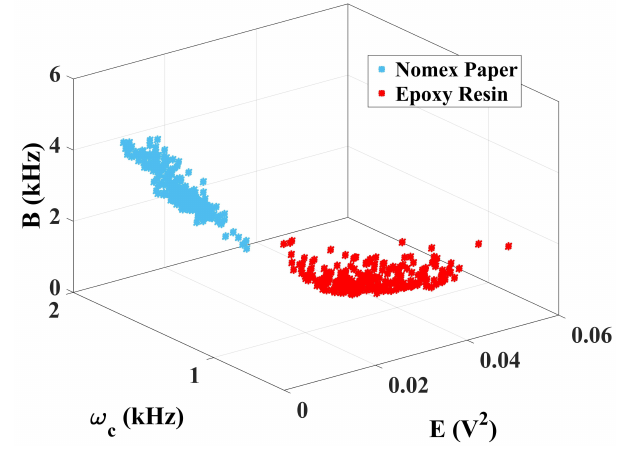
Figure 6. Chromatic technique for piezoelectric transducer.